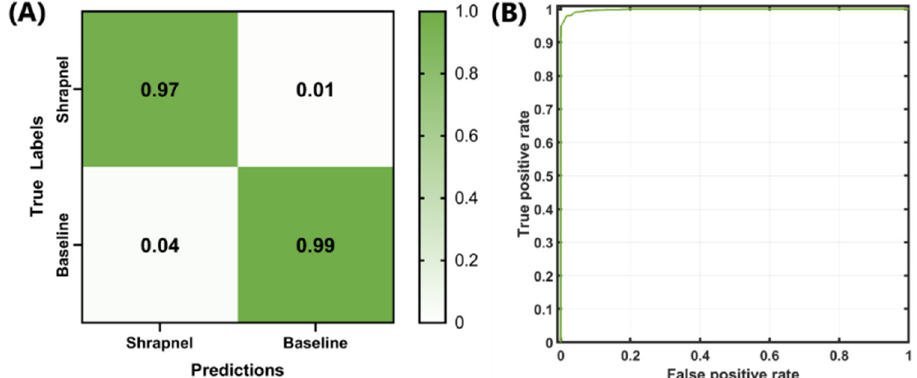
Figure 3. Final backend analysis of trained Bayesian-optimized ShrapML model includes ( A ) con- fusion matrix, ( B ) ROC analysis from test image sets.